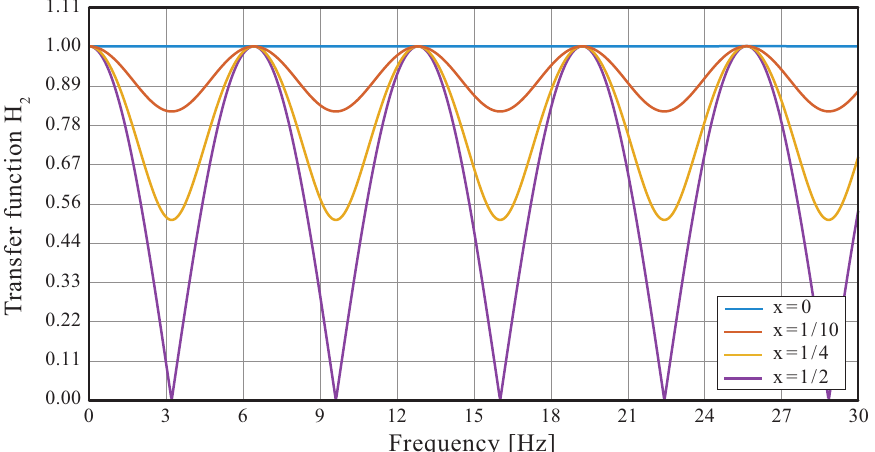
Figure 4. Modulus of transfer function H 2 at four locations on the